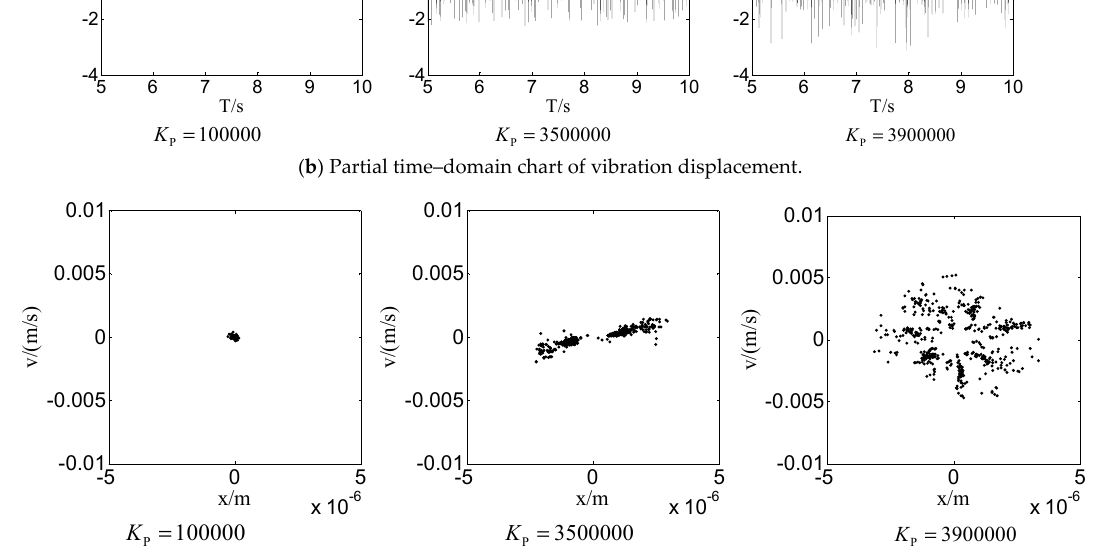
Figure 8. Effect of proportional parameter on hydraulic cylinder vibration response. Figure 8. E ff ect of proportional parameter on hydraulic cylinder vibration response.